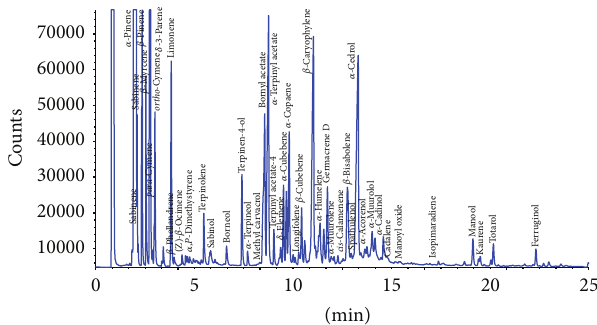
Figure 1: Essential oil chromatogram from cones of Cupressus sem- pervirens